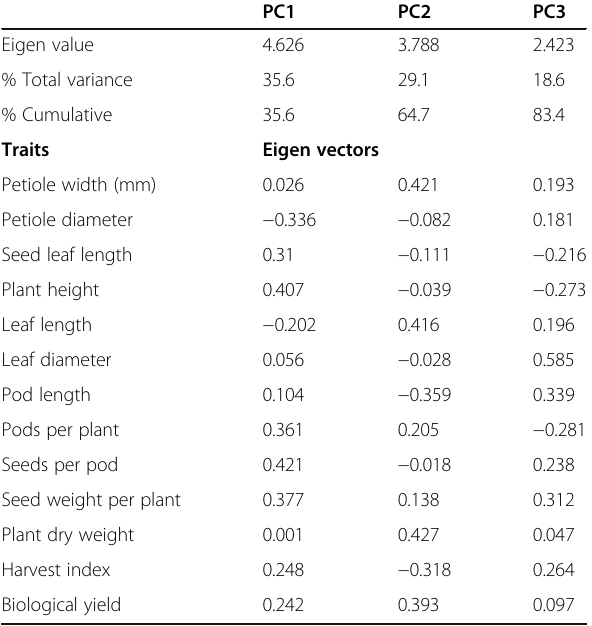
Table 3 Principal component analysis of 7 Vigna radiata genotypes based on 13 traits